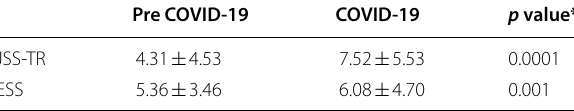
Table 4 JSS-TR and ESS scores before and after